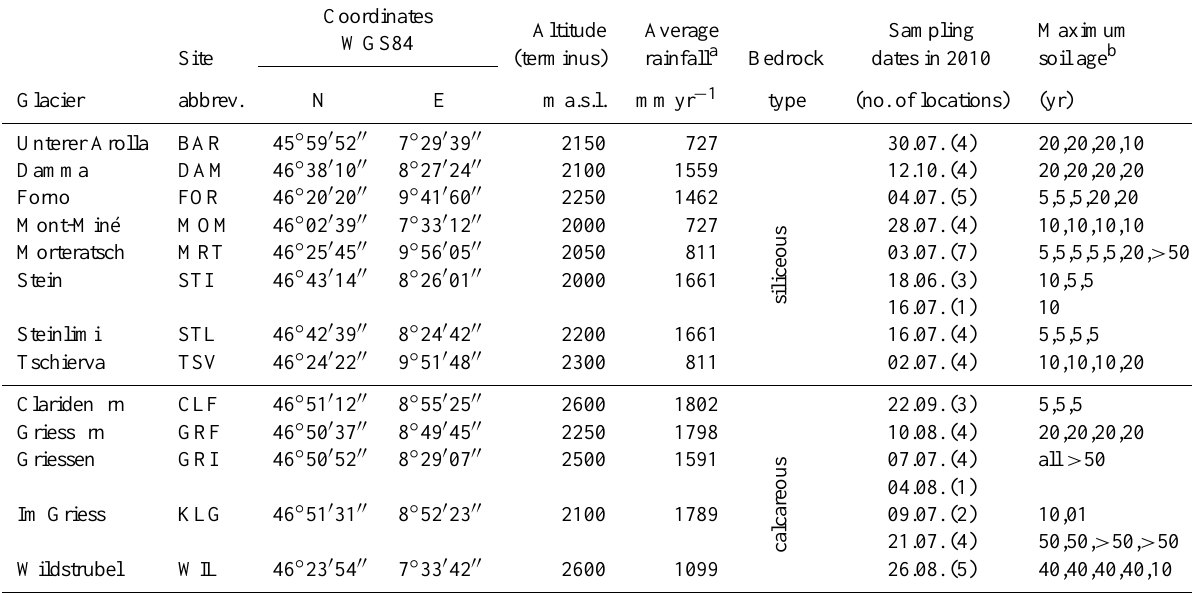
Table 1. Overview of sampled glacier forefields and site characteristics. The date of sampling (dd.mm.) for each site is followed by the number of locations sampled on this date in parentheses. Soil age is reported in sampling sequence for each